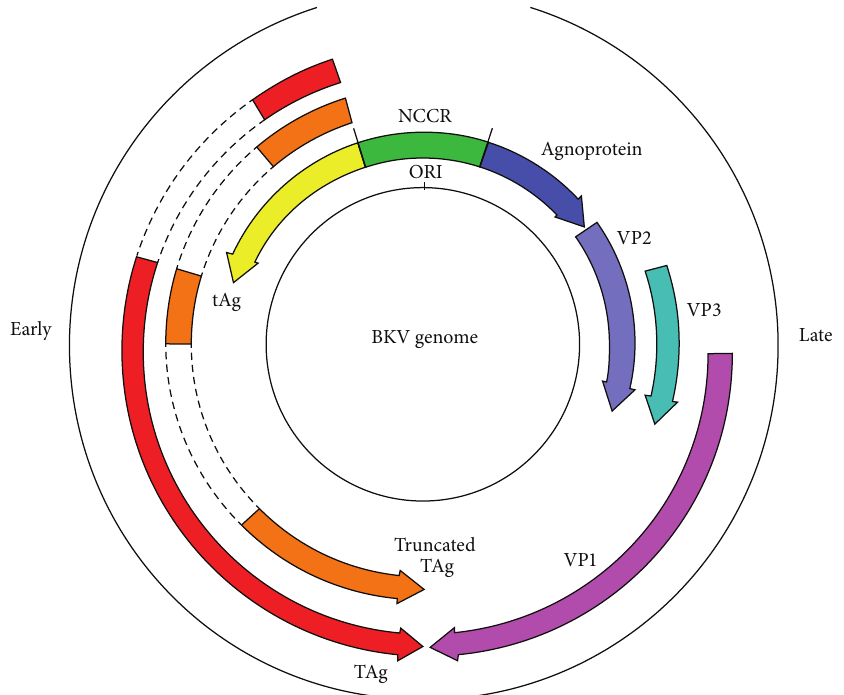
Figure 2: Schematic diagram illustrating the organisation of the dsDNA genome of BK virus. The open reading frames are represented by arrows with alternative splicing events highlighted by dashed lines. The origin of replication (ORI) within the noncoding control region (NCCR), from which transcription of early and late mRNAs proceeds, is indicated. The agnoprotein and truncated T antigen genes have not been described in all